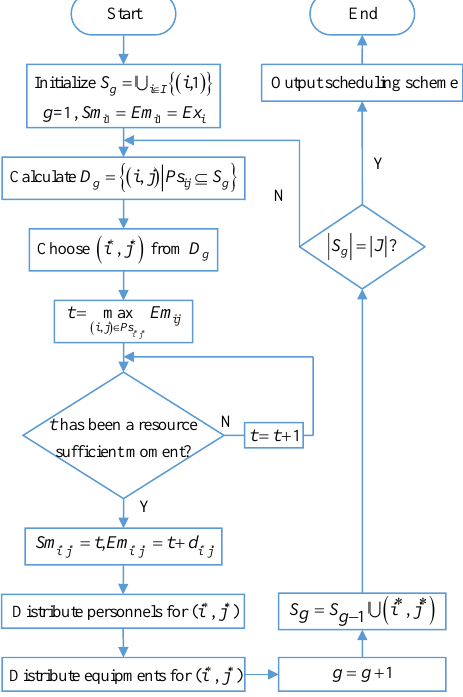
Figure 6. Flowchart of serial scheduling generation scheme (SSGS).